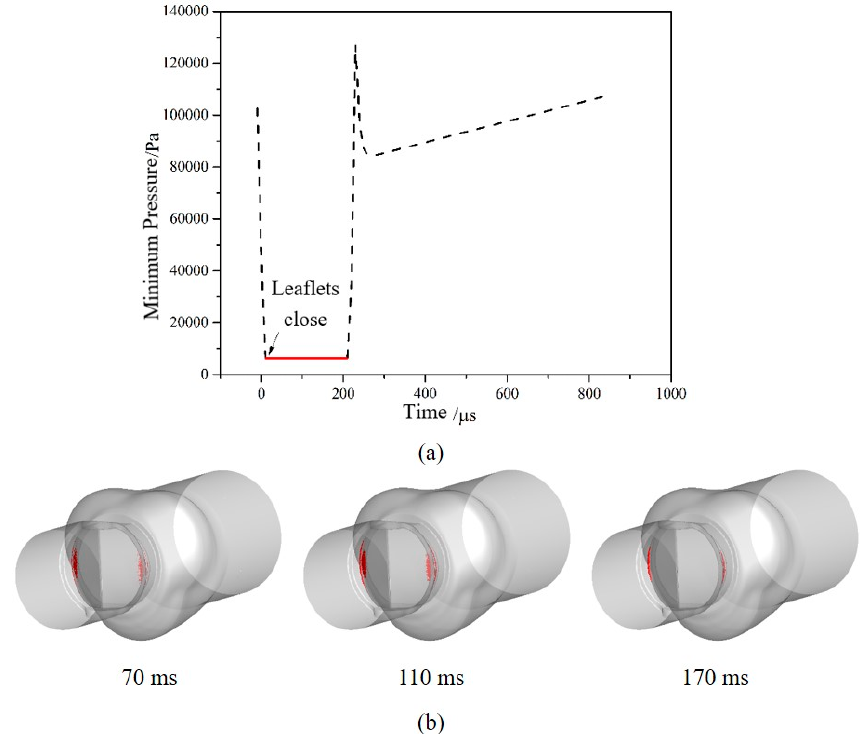
Figure 8. The variation of minimum pressure and volume of vapor phase: ( a ) The minimum pressure around the moment of valve closing; ( b ) The volume distribution of the vapor phase after valve closing.